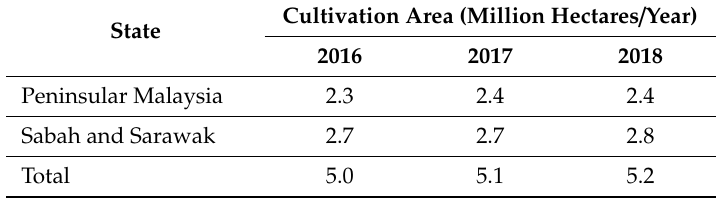
Table 1. The cultivation field for oil palm in